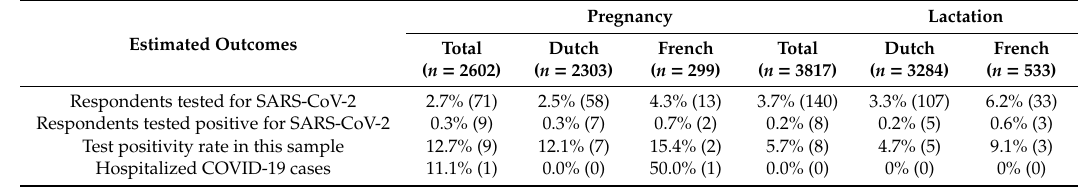
Table 1. Estimates of SARS-CoV-2 infection in the study